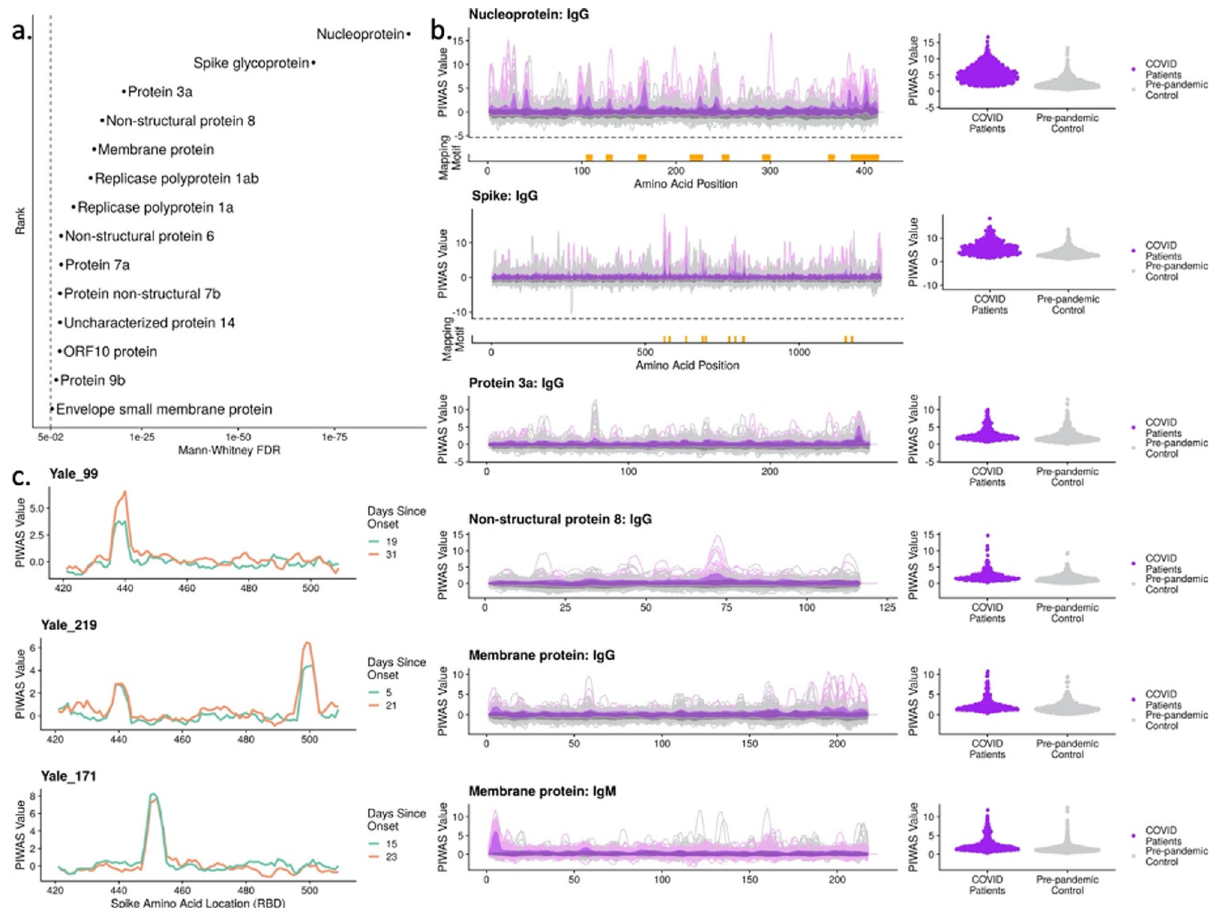
Fig. 2 Bioinformatic analysis of SERA antibody repertoires identi fi es the antigens and epitopes involved in the SARS-CoV-2 immune response. a PIWAS statistical ranking of kmer enrichments across the SARS-CoV-2 proteome using the Mann – Whitney false-discovery rate (FDR). Multiple antigens in addition to spike and nucleoprotein showed signi fi cant enrichment for one or more epitopes. b PIWAS kmer enrichments from COVID-19 repertoires versus pre-pandemic controls across statistically signi fi cant antigens. PIWAS values = number of standard deviations above the mean of 1500 pre- pandemic controls. PIWAS tiling (left): Dark purple = average COVID-19 patient signal, light purple = 95th quantile band for COVID-19 patient signal, dark gray = average pre-pandemic control patient signal, light gray = 95th quantile band for pre-pandemic patient signal. PIWAS distribution (right): One point per patient of maximum PIWAS value across each protein. IMUNE motifs largely mapped to the same prominent epitopes that were identi fi ed by PIWAS. Epitopes on spike and nucleoprotein discovered by IMUNE are shown below each antigen (orange bars). All antigens were found to be statistically different from controls as shown in a . c Longitudinal samples from individual subjects enabled identi fi cation of RBD-speci fi c signals that emerged over time but were not conserved across COVID-19